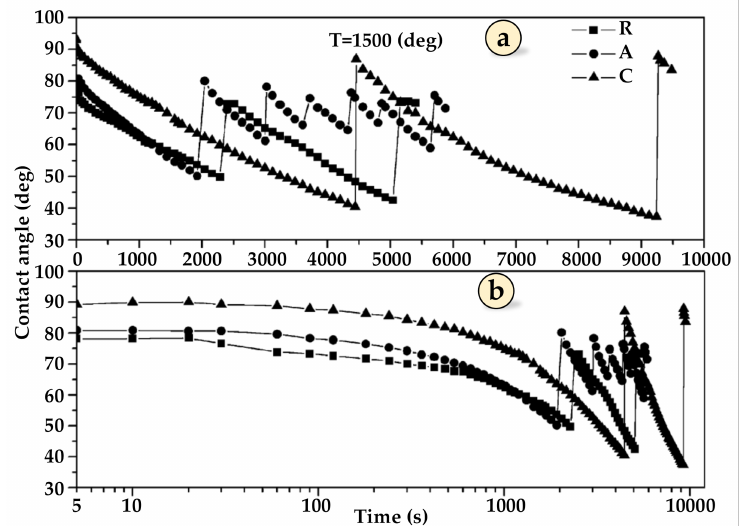
Figure 2. The effect of crystallographic orientation of α -Al 2 O 3 , i.e., R (0112), A (1120) and C (0001), on the wetting and adhesion, reproduced from [48] with permission of Elsevier, 2003. ( b ) is the logarithmic time scale of ( a ), showing a maximum contraction at ~30